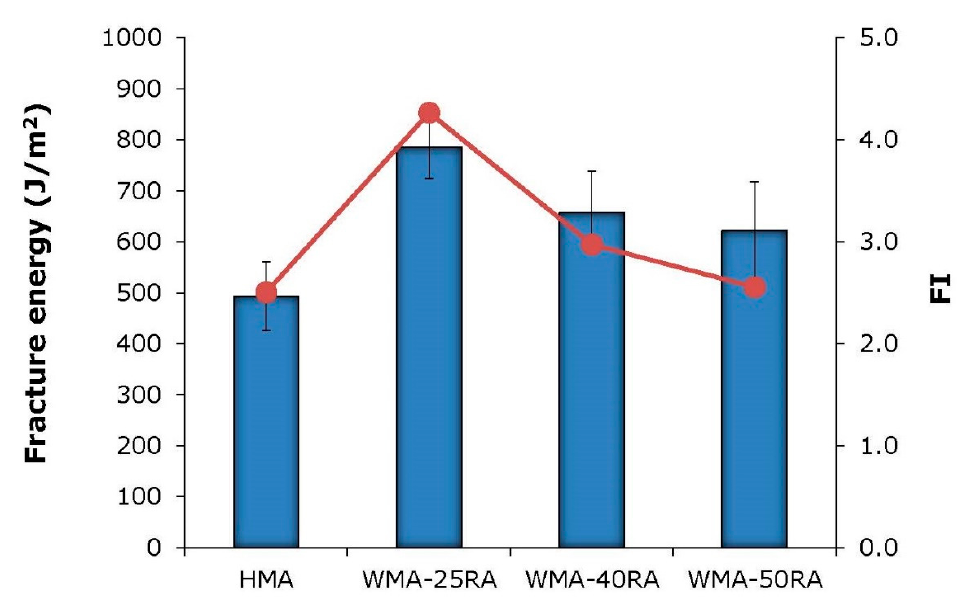
Figure 8. Fracture energy and flexibility index results.